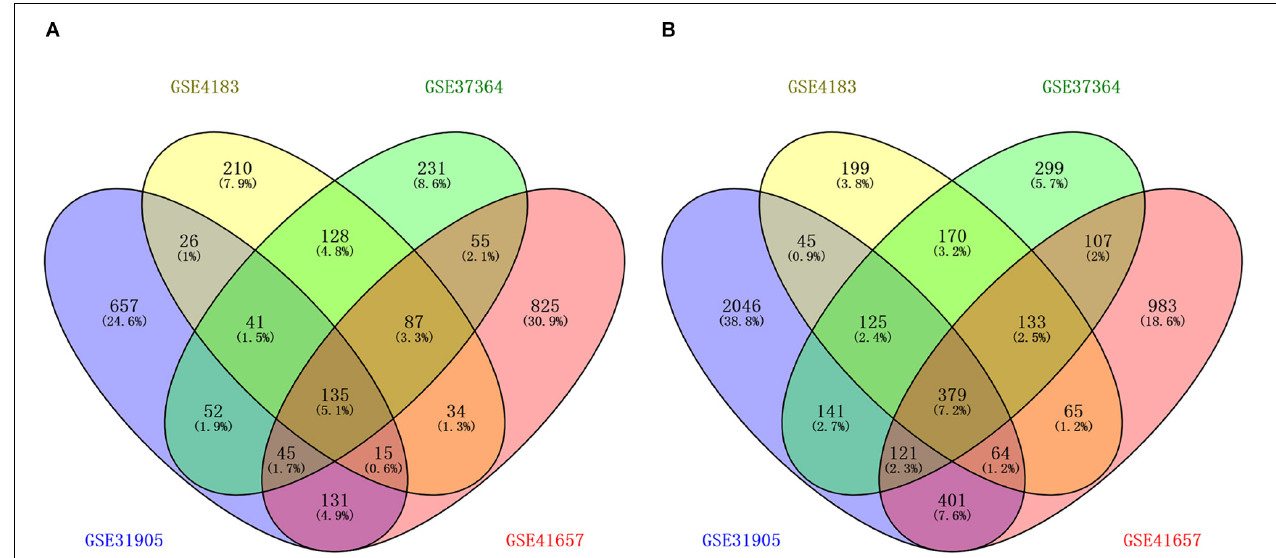
FIGURE 1 | Identification of differentially expressed genes in four mRNA expression profile datasets (GSE31905, GSE4183, GSE37364, and GSE41657). (A) The overlapping up-regulated genes in four gene expression profiles; (B) the overlapping down-regulated genes in four gene expression profiles. Each circle depicts the number of expressed genes. Overlapping expressed genes shared more than one dataset is represented in the area of intersection between 2